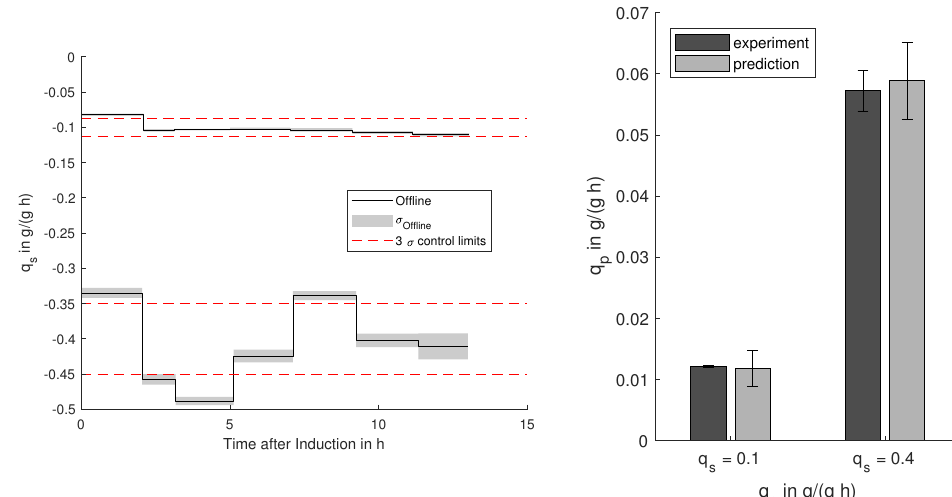
Figure 5. Control limits for high ( − 0.4 g/(g h)) and low ( − 0.1 g/(g h)) biomass-specific substrate uptake ( q s ) during induction with the offline-determined uptake rates and their standard deviation σ offline . Resulting and predicted productivities q p of the two processes with the 99% prediction confidence and standard deviation for the measured productivities.